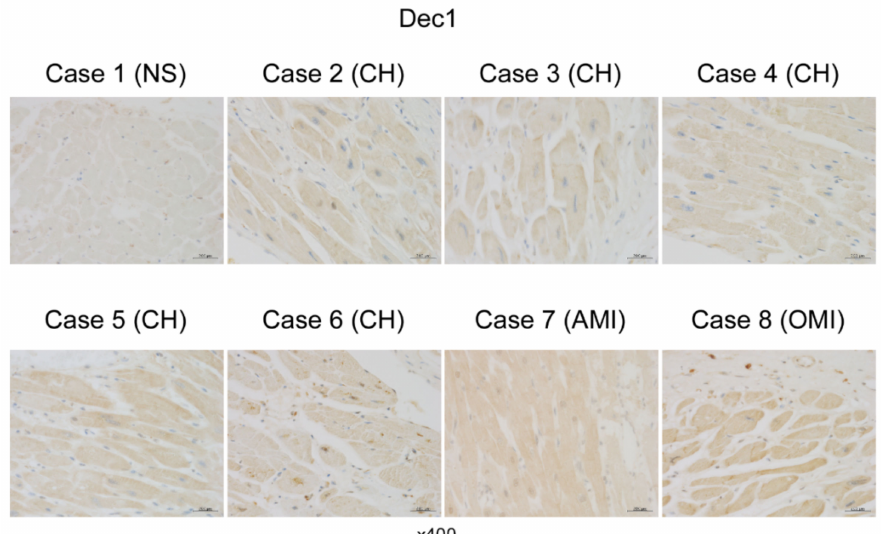
Figure 7. Dec1 expression is increased in the myocardial cells of cardiac hypertrophy and myocardial infarction. Immunohistochemical detection of Dec1 in human cardiac diseases. Representative image of Dec1 immunoreactivities from case 1 to case 8. Case 1 (control) had no significant findings (NS). Cases 2 to 6 are cardiac hypertrophy (CH). Case 7 is acute myocardial infarction (AMI), and case 8 is an old myocardial infarction (OMI). Magnification 400 ×